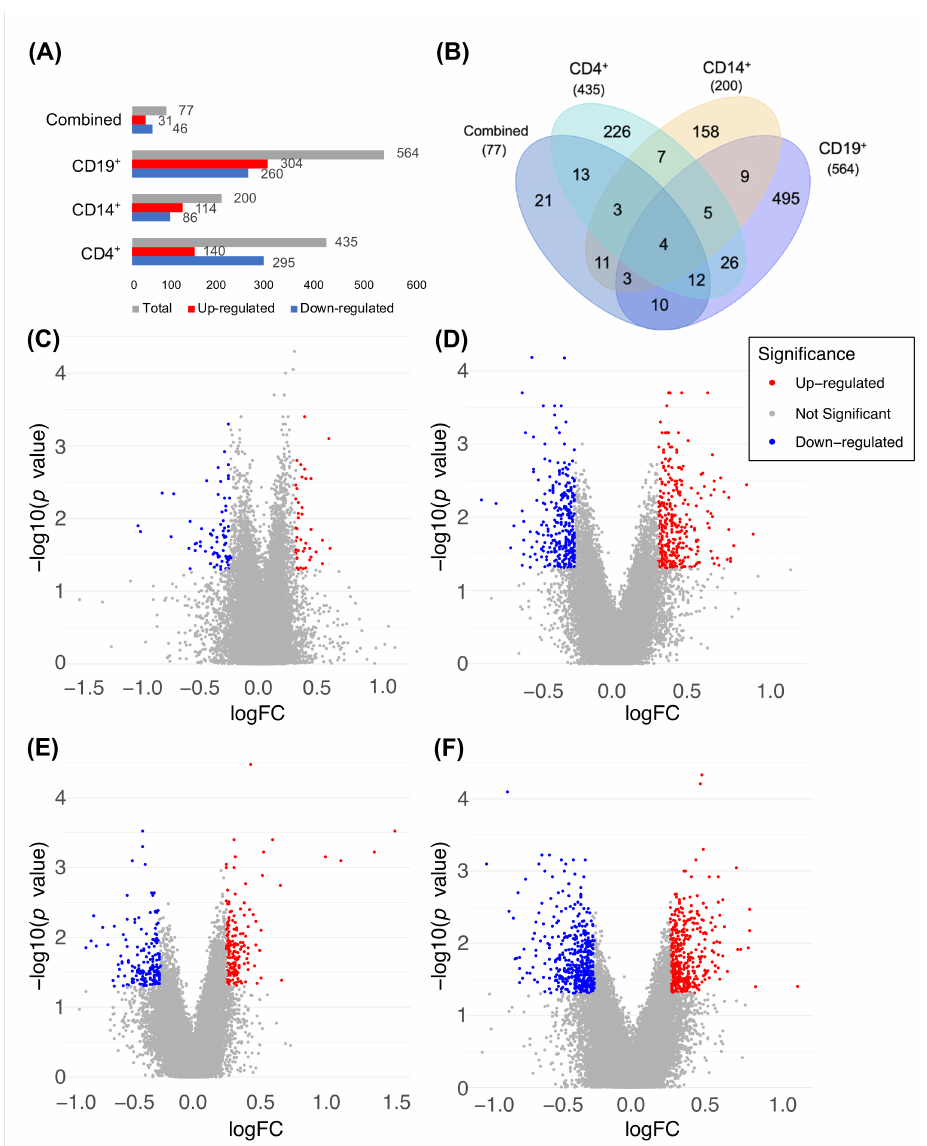
Figure 2. Differentially expressed genes (DEGs) are different between each cell type. More DEGs are down-regulated after vitamin D treatment than DEGs up-regulated in CD4 + , while combined CD14 + and CD19 + have more up-regulated DEGs than down-regulated ones ( A ). The majority of DEGs are cell-type-specific, while only four genes are shared between CD4 + , CD14 + , CD19 + , and combined (all cell types combined) ( B ). Nominal p value < 0.05, fold change of >1.2 × . The combined dataset ( C )